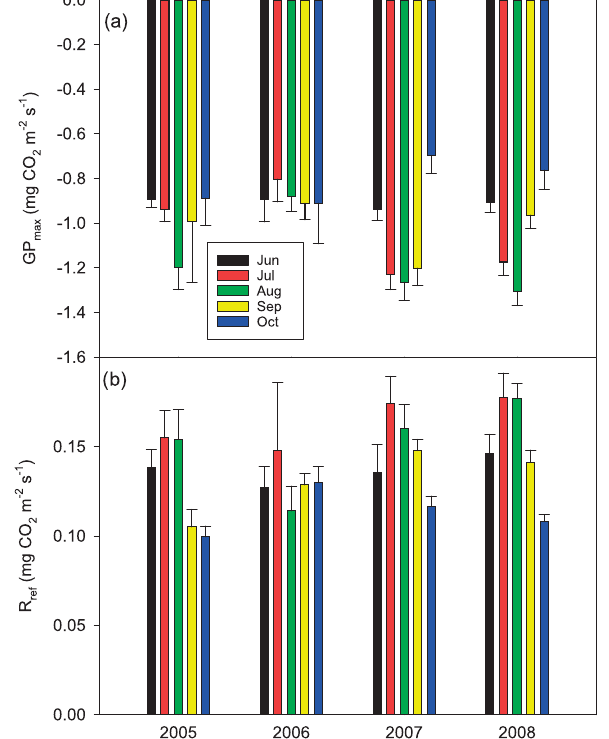
Figure 5. Parameter values (a) GP MAX x and (b) R REF ± 95% con- fidence intervals (see Eqs. A2 and A3 in Appendix A, respectively) for June–October in 2005–2008. For the respiration model, a con- stant value of E 0 = 200K was used, and the GPP model was used here without the VPD term.